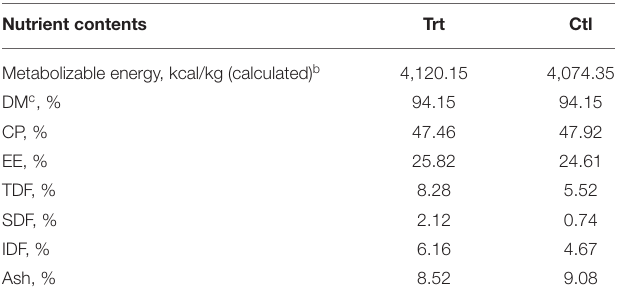
TABLE 1 | Nutrient content and ingredient composition a of the control and treatment diet on a dry-matter